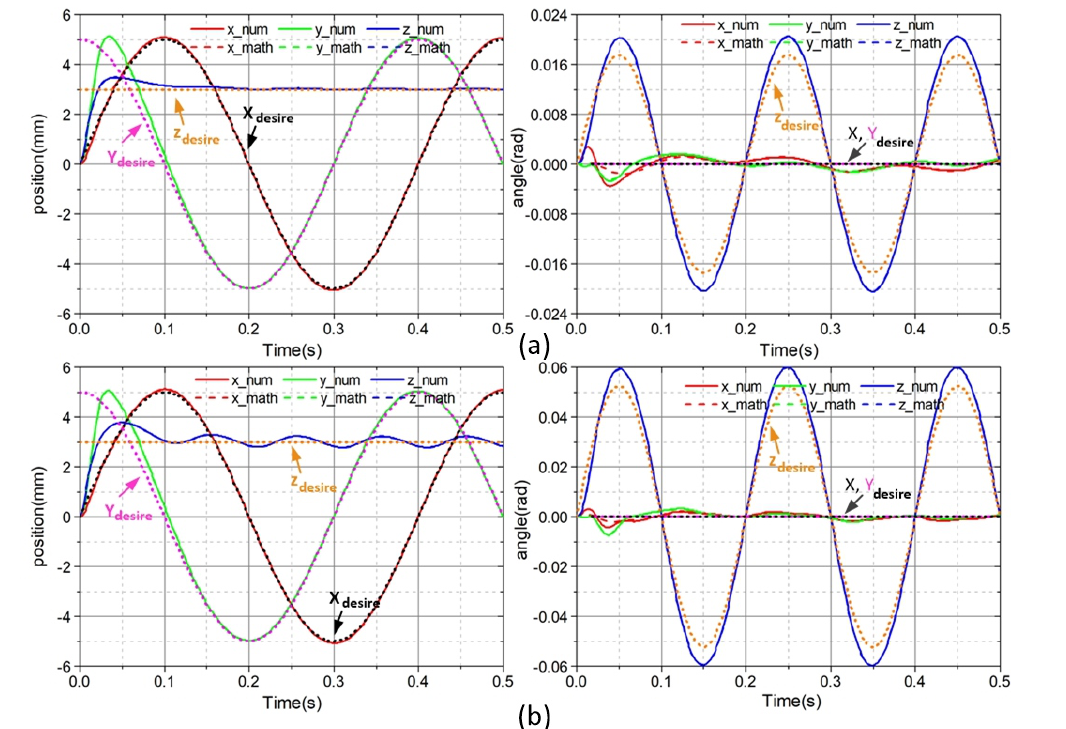
Figure 10. Numerical model and mathematical model based simulation models’ results. ( a ) γ = π sin ( 10 π t ) , ( b ) γ = π sin ( 10 π t ) 60 180